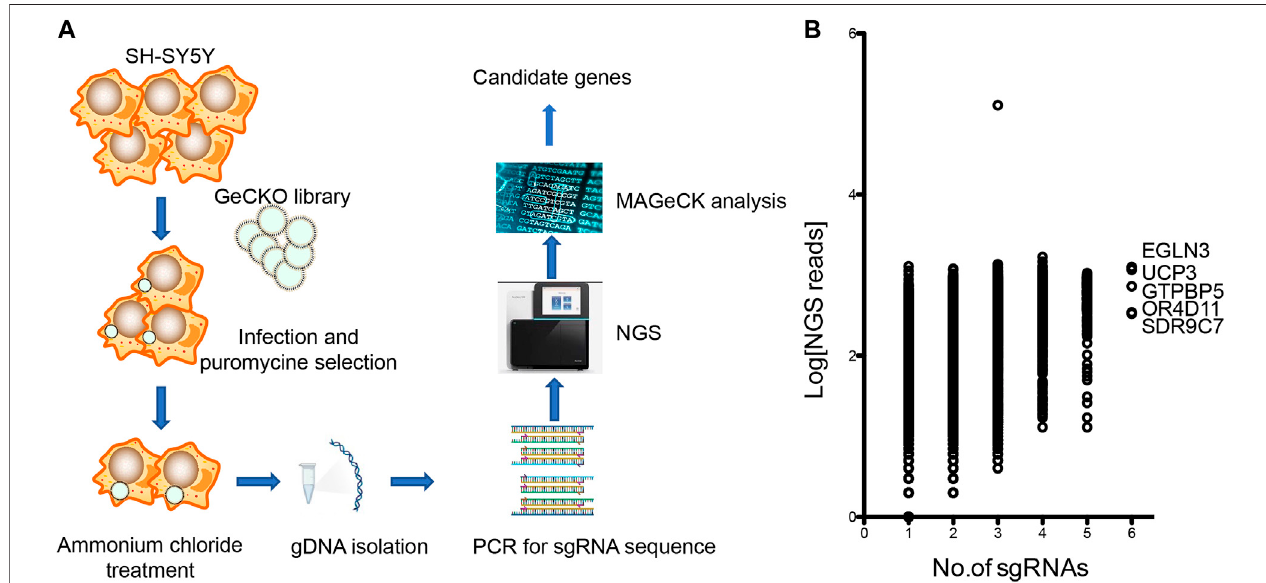
FIGURE 1 | The GeCKO screen to identify genes whose loss conferred ammonia resistance. (A) Schematic of forward GeCKO screen in SH-SY5Y cells using pooled sgRNA libraries. (B) Genes identi fi ed in the screen for ammonia resistance. The X-axis was the number of unique sgRNAs for each gene. The Y-axis showed Log10 of the average of sequence